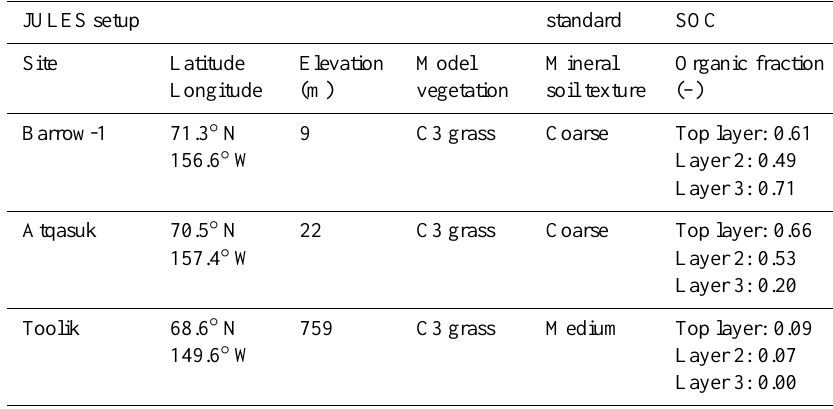
Table 4. JULES point simulations at USDA-NRCS soil climate research sites.